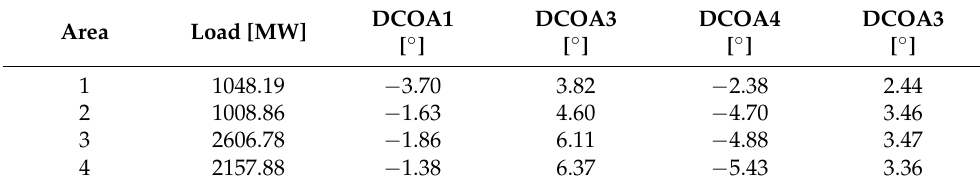
Table 2. Parameters of the operational areas in IEEE 39-bus